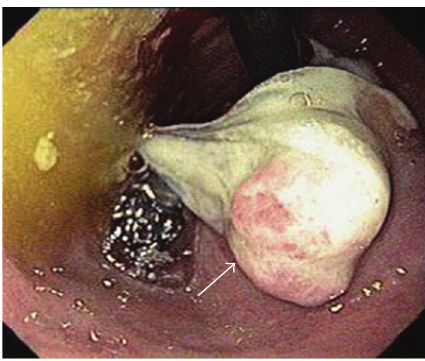
Figure 1: A large, fungating gastric cardia mass (arrow) suspicious for neoplasm seen on esophagogastroduodenoscopy (EGD).